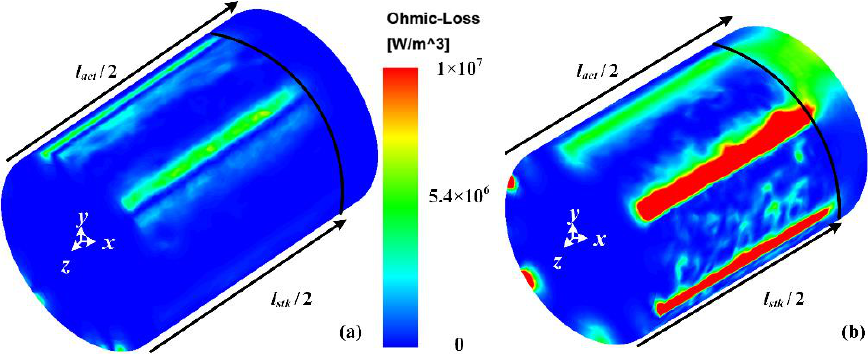
Figure 8. Distribution of eddy current loss according to the current waveform: ( a ) sinusoidal and ( b ) PWM current.